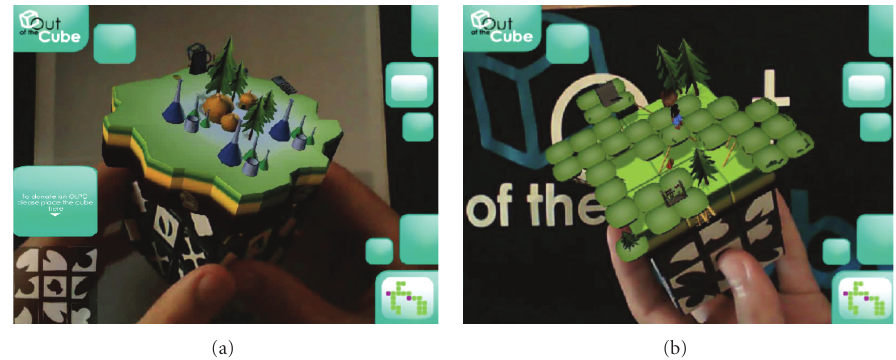
Figure 1: Augmented Reality games based on Rubik’s Cube. (a) A village puzzle game and (b) a skill-based maze walking